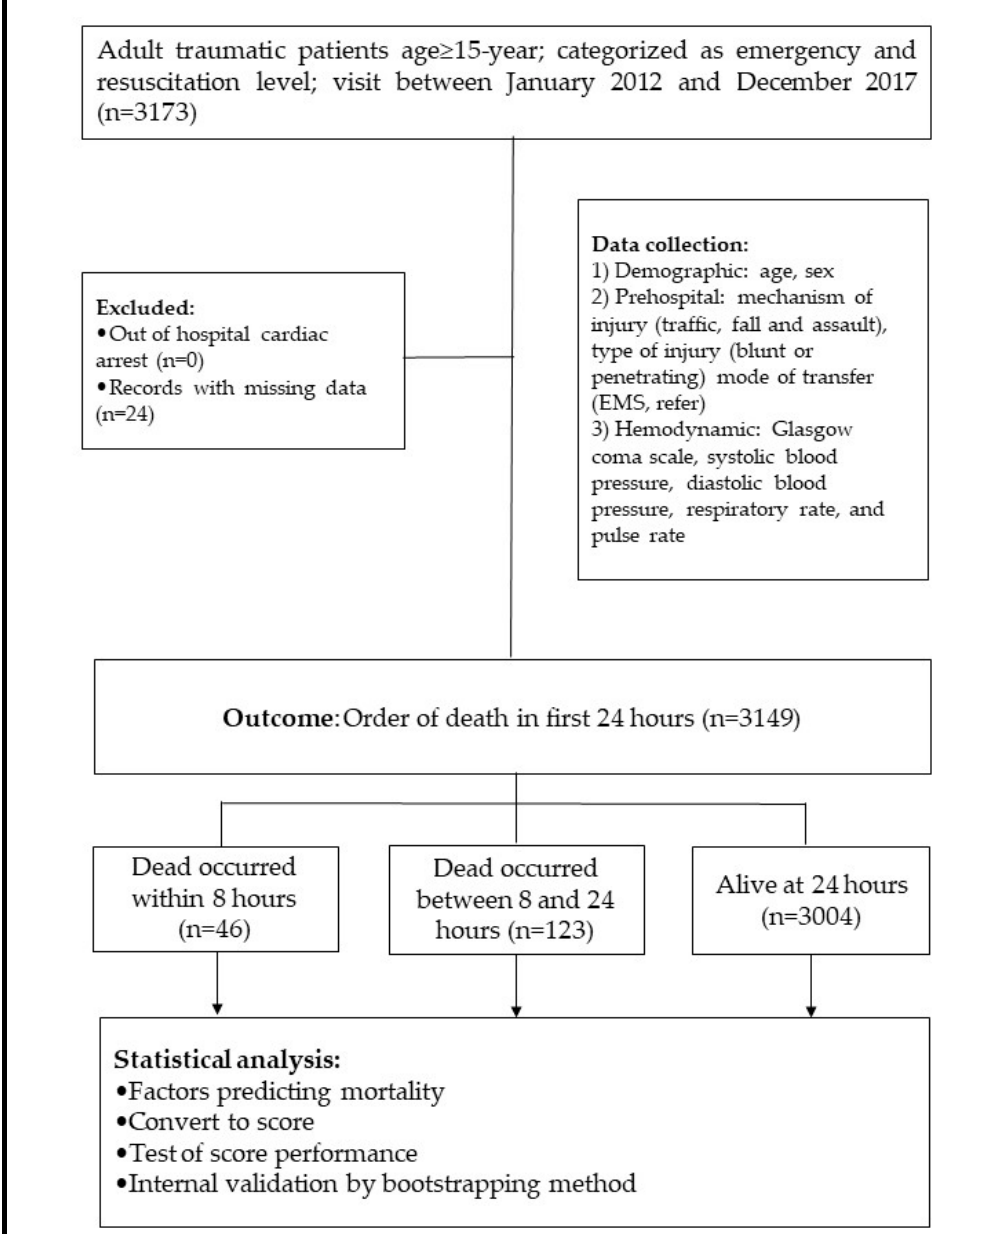
Figure 1. Flow diagram to show the development of TERMINAL-24 score.